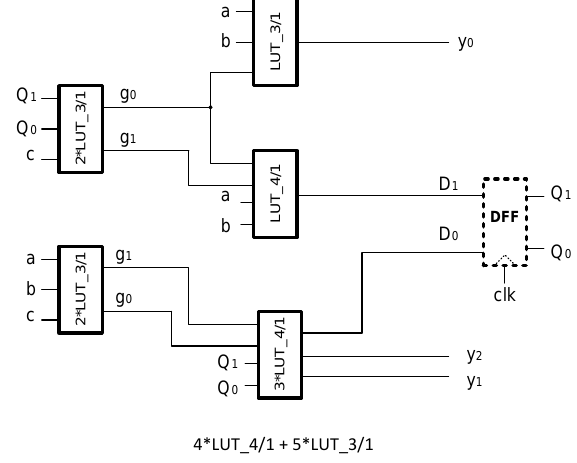
Figure 12. Result of technology mapping oriented to LUT_4/1.